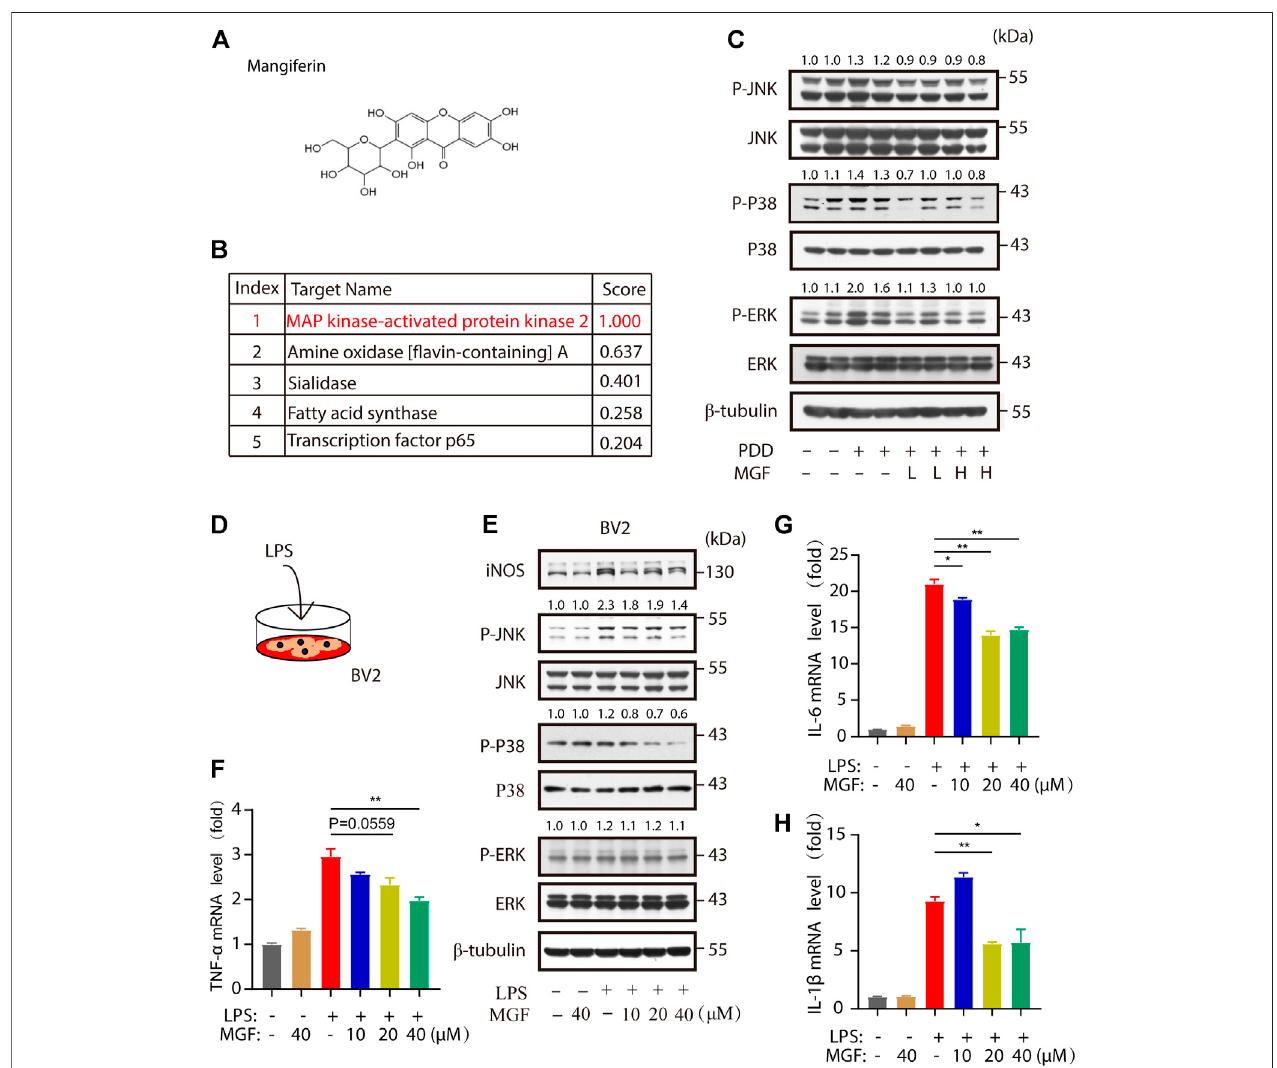
FIGURE5| MGF-regulatedmitogen-activatedproteinkinase(MAPK)signaling invivo and invitro . (A) MGFstructure. (B) PotentialproteintargetsofMGFrankedby the standard score of the probabilities. (C) Immunoblotting analysis of p-JNK, JNK, p-p38, p38, p-ERK, ERK, and β -tubulin protein levels in the hippocampus of mice. The number representsthenormalized quantitativevalueoftheprotein. (D) Theschematic representation ofLPSstimulation inBV2cells. (E) Immunoblottinganalysisof iNOS, p-JNK, JNK, p-p38, p38, p-ERK, ERK, and β -tubulin protein levels from BV2 cells after being treated with MGF for 0.5 h and then stimulated LPS (1 μ g/ml) for 6 h. The number represents the normalized quantitative value of the protein. (F – H) RT-PCR analysis of TNF- α , IL-6, and IL-1 β mRNA levels in BV2 cells after being treated with MGF for 0.5 h and then stimulated LPS (1 μ g/ml) for 6 h. Error bars are mean ± SEM. * p < 0.05, ** p < 0.01, and *** p < 0.001.